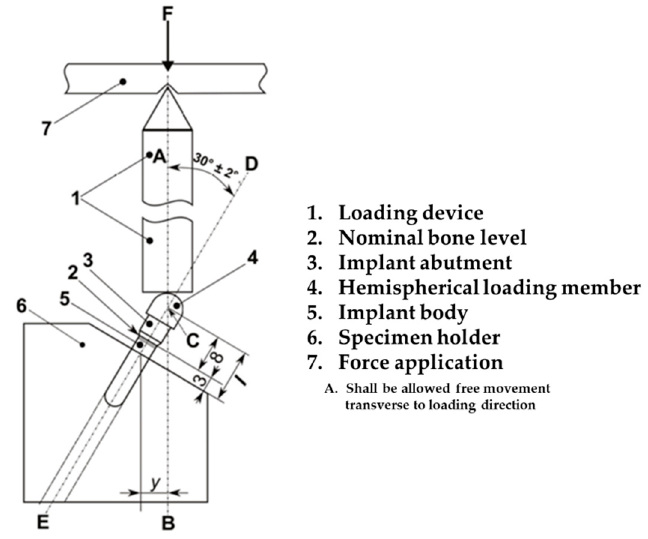
Figure 5. Schematic of the static shear-compression loading experiment. Schematic of the test setup based on the revised ISO 14801:2016.